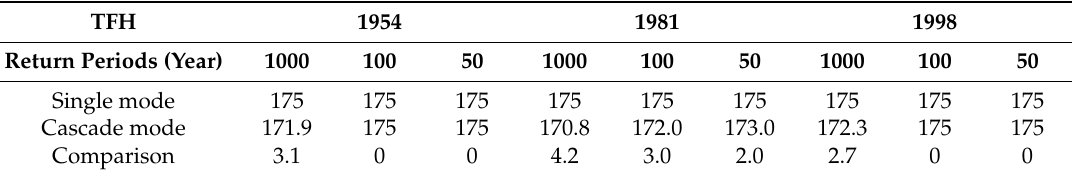
Table 7. The highest water levelof Three Gorges Reservoir considering the flood control for the Jingjiang and Chenglingji areas